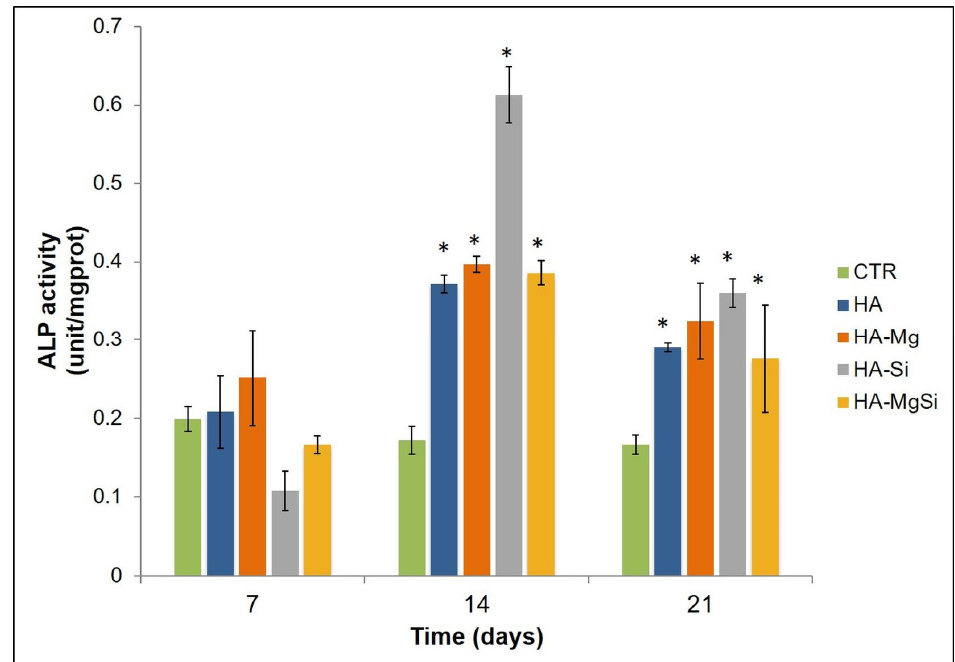
Figure 9. Confocal microscopy images of BMSC seeded on ceramic scaffolds after seven days of culture. Viable cells in- corporated DiIC18(3) label (red) into their membrane, and nuclei were stained with DAPI (blue). Individual blue and red channels are shown, followed by merged images (scale bar = 50 μ m). Images are representative of three independent experiments.